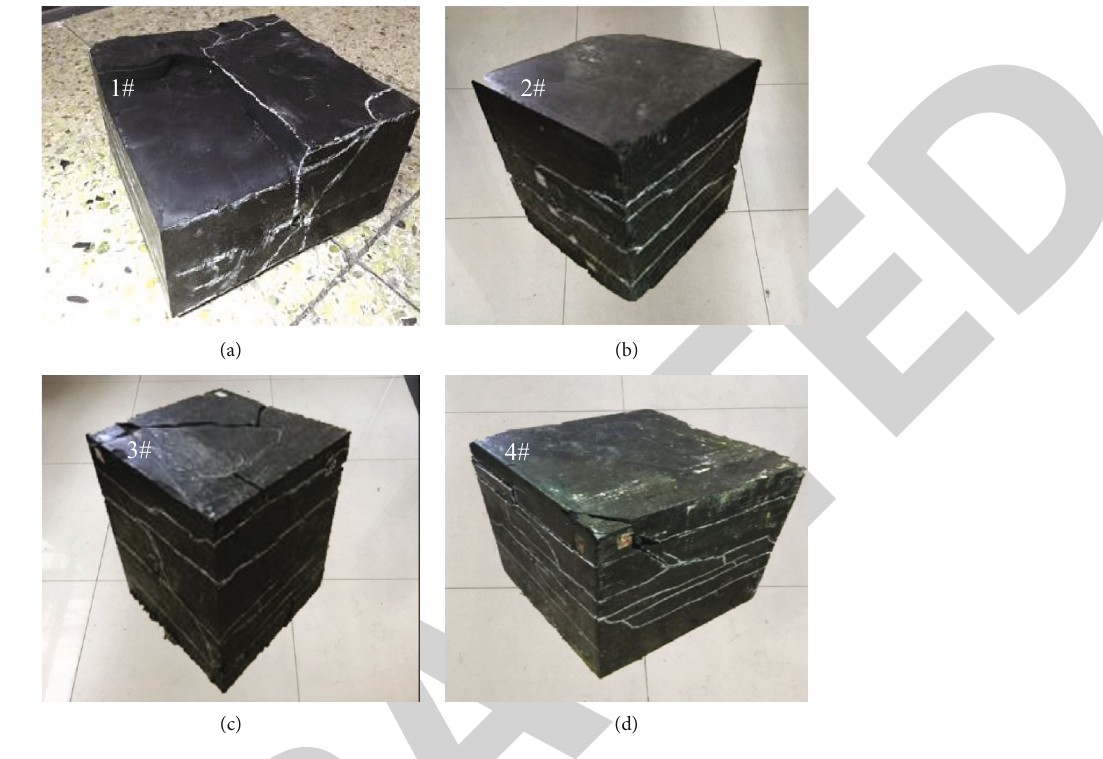
Figure 5: Fracture geometry after fracturing test.